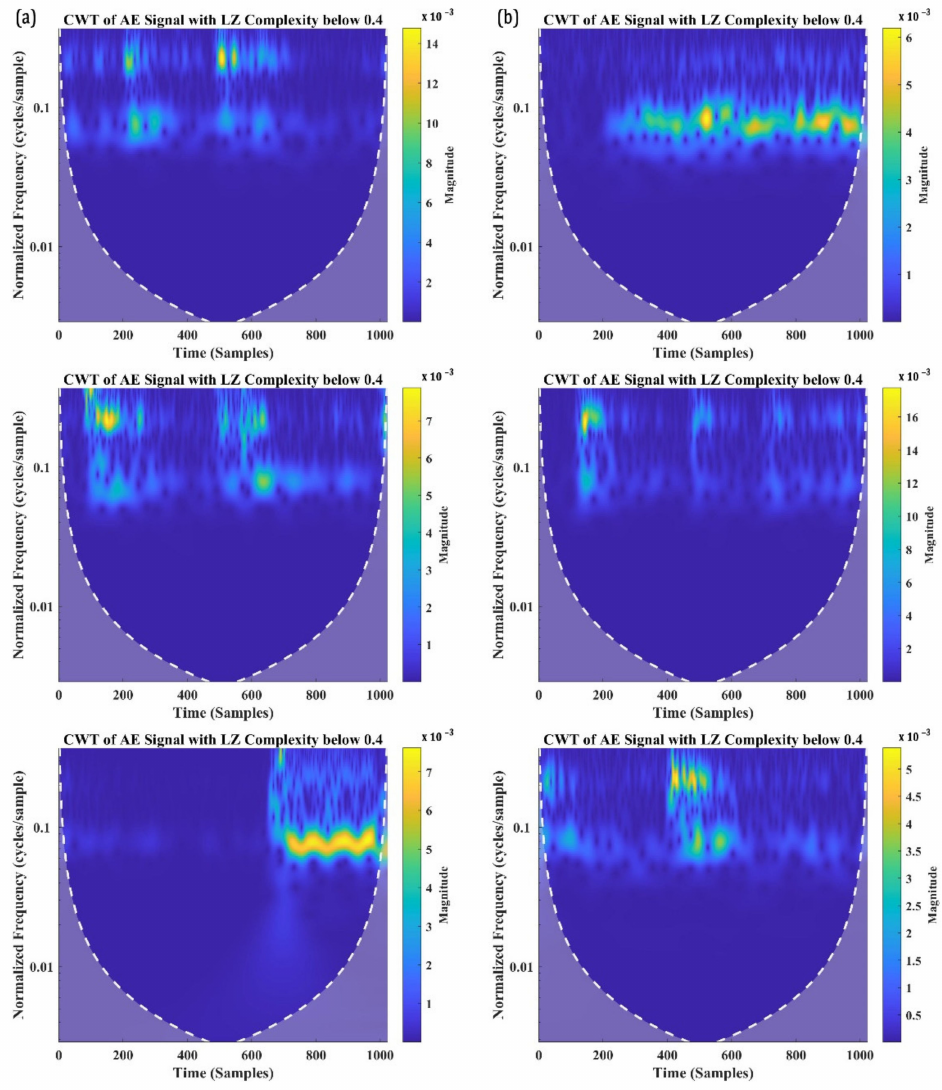
Figure 10. CWT of the AE signals with W.P-Freq between 200 kHz and 300 kHz and LZ complexity below 0.4 recorded from SBS specimens tested at ( a ) 100 ◦ C and ( b ) 120 ◦